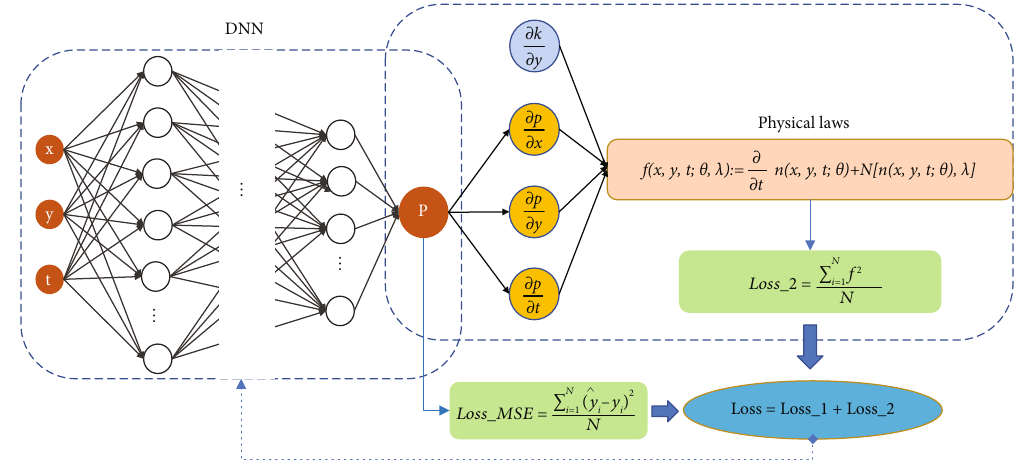
Figure 1: Framework of the PINN